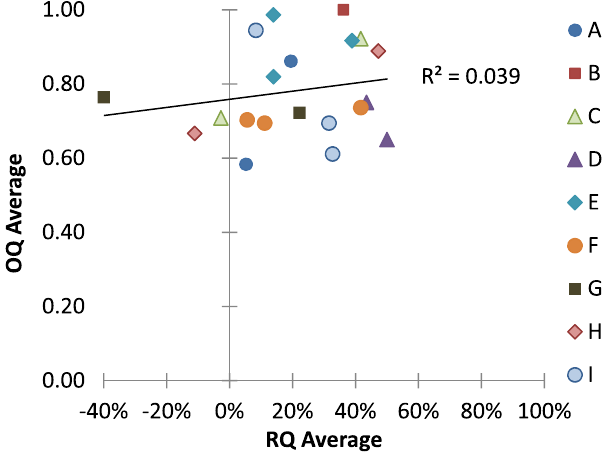
FIG. 4. Student performance on OQ vs RQ, averaged across all comparison questions, with linear regression and corresponding Pearson correlation coefficient ( R 2 ¼ 0 . 039 ). Error bars are not shown on the plot for clarity; the average standard error was (cid:2) 6 % for the RQ and (cid:2) 0 . 03 for the OQ.